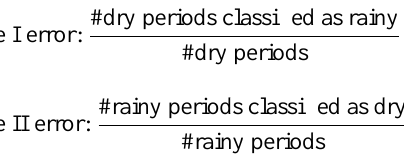
Fig. 13. Illustration of the classification performances for the uni- variate Markov switching algorithm (MSU), the simple threshold, the Factor Graph and the moving window on a subset of dataset 1 (stationary case). Displayed are the observations from channel 1. The time is given in UTC.